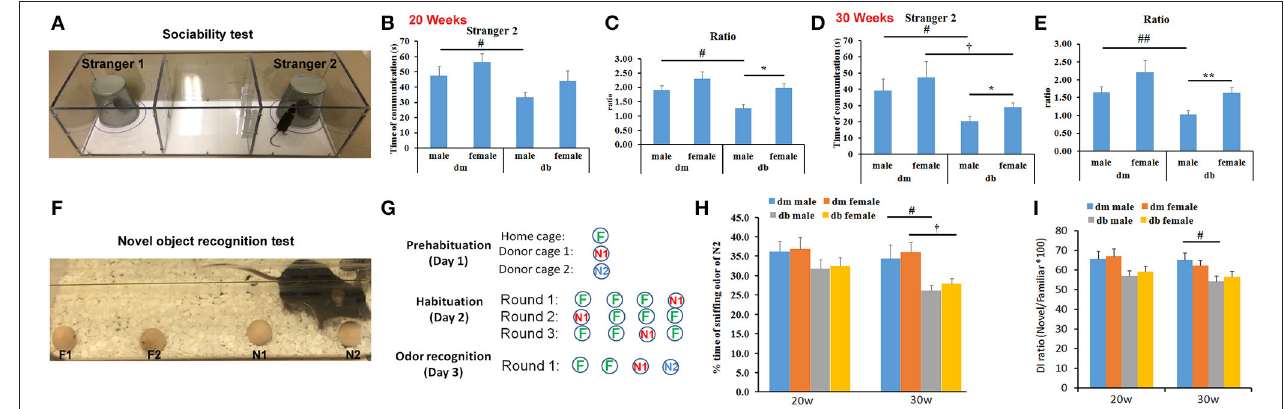
FIGURE 2 | Social discrimination and recognition memory between males and females. A three-chambered box (A) and wooden beads (F) were used for social novelty test (A–D) and odor–based novelty recognition test (F–I) , respectively. Male db/db mice spent significantly more time on exploring a new stranger mouse ( B–E , stranger 2), compared to female db/db mice. But there is no significant difference in time spent on a novel bead ( H , N2 bead) and novel object discrimination index (DI, I ) between male and female db/db mice. Compared with male and female non-diabetic db/m mice, db/db mice decreased time spent on exploring an unfamiliar mouse and recognizing the novel odor bead (B–E) . The ratio (C,E) refers to the time spent on a new stranger mouse (stranger 2) divided the time spent on an old stranger mouse (stranger 1). Illustration of the experimental approach (circles correspond to odor beads and familiar, novel beads were labeled as green “F” and red or blue “N”, respectively). Data in novelty recognition test (H) were presented as the percentage of time spent on N2 relative to the total amount of time spent with all beads. N1 = familiar odor bead; N2 = unfamiliar novel odor bead. * P < 0.05, ** P < 0.01 db/db male vs. db/db female; # P < 0.05, ## P < 0.01 dm male vs.